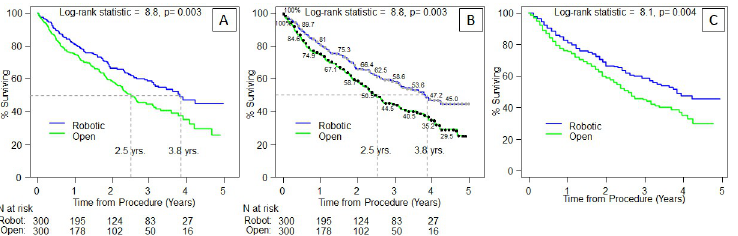
Fig 3. Kaplan-Meier curve worked example: Example data for Method 3 Guyot algorithm and worked example. Panel A is a graph that might appear in a publication. Panel B shows the “digitized” version with time and KM points, and panel C shows the re-constructed individual patient data using the digitization and n at risk as input. See S1 Appendix for full R